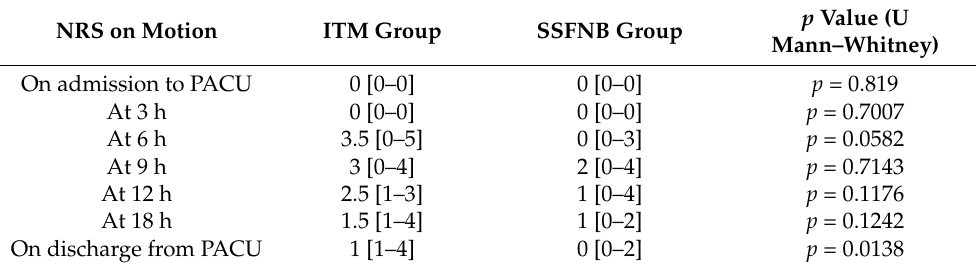
Table 4. Postoperative pain levels on